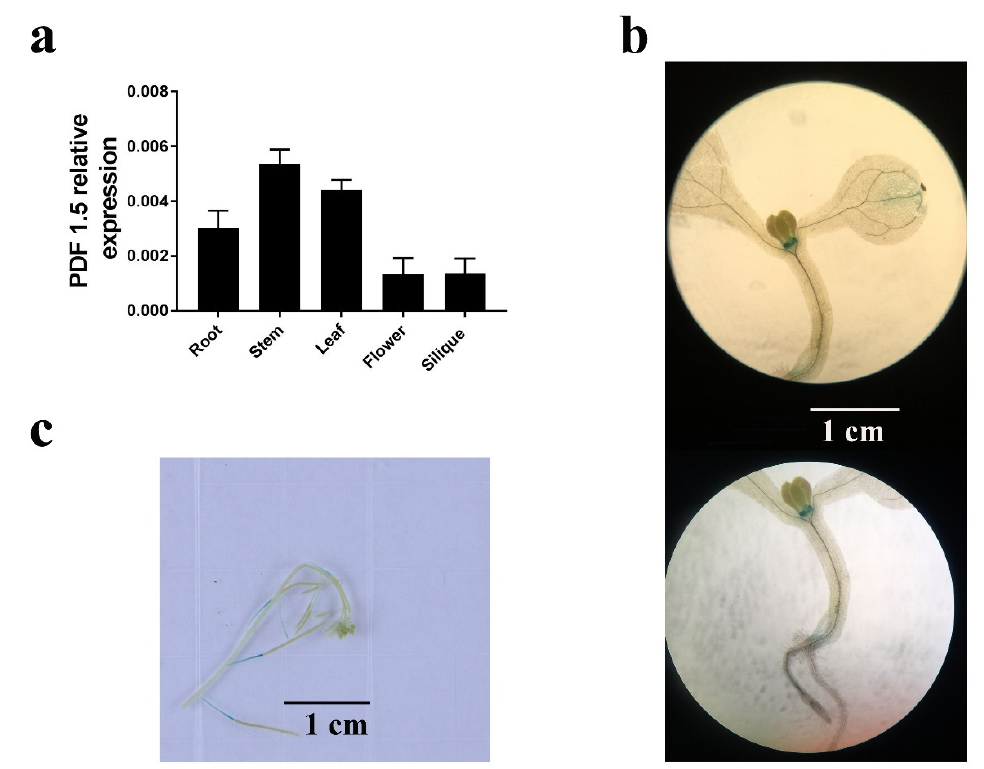
Figure 5. Expression pattern of AtPDF1.5 . ( a ) Analysis of the relative expression level of AtPDF1.5 in the different A. thaliana tissues by quantitative PCR (qPCR). Tissues were harvested from 4-week-old hydroponically grown plants (roots, stems, leaves, flowers, and siliques). Actin was used as the internal control. ( b , c ) Histochemical localization of β -glucuronidase (GUS) activity in transgenic plants expressing the GUS reporter gene under the control of the proAtPDF1.5 promoter. Bar height represents mean and error bars indicate standard deviation. Different letters on bars indicate significant differences based on Tukey’s HSD ( p < 0.05). The statistical analysis was per- formed on different treatment genotypes. Six replicates were used for measurements.